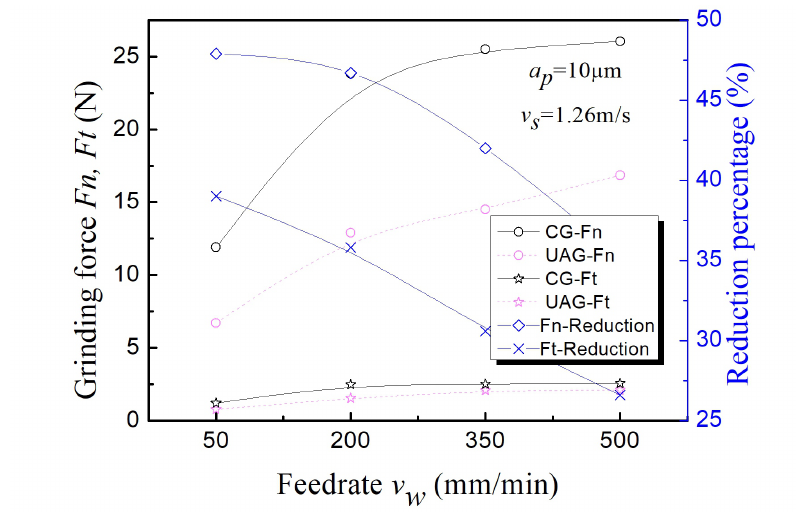
Figure 11. End grinding: the influence of feed speed changes on the grinding force.